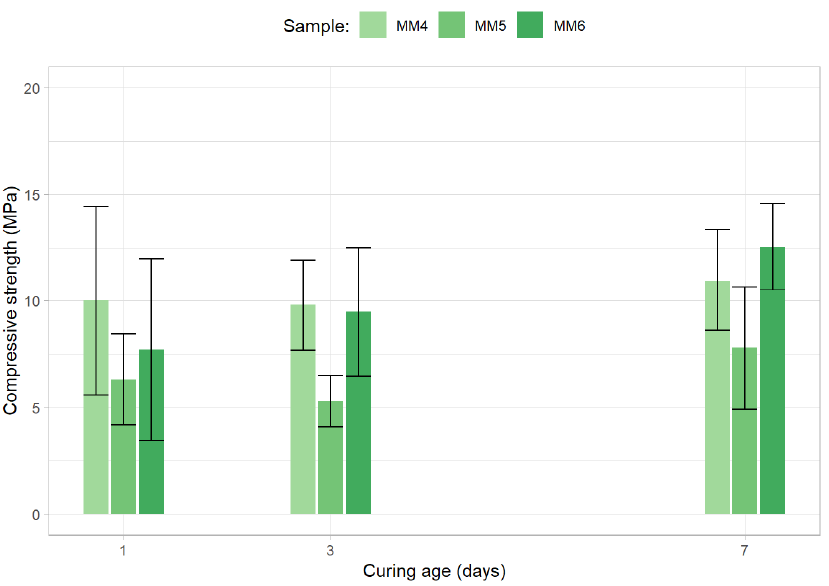
Figure 8. Compressive strength results for the second round of the initial optimization stage.